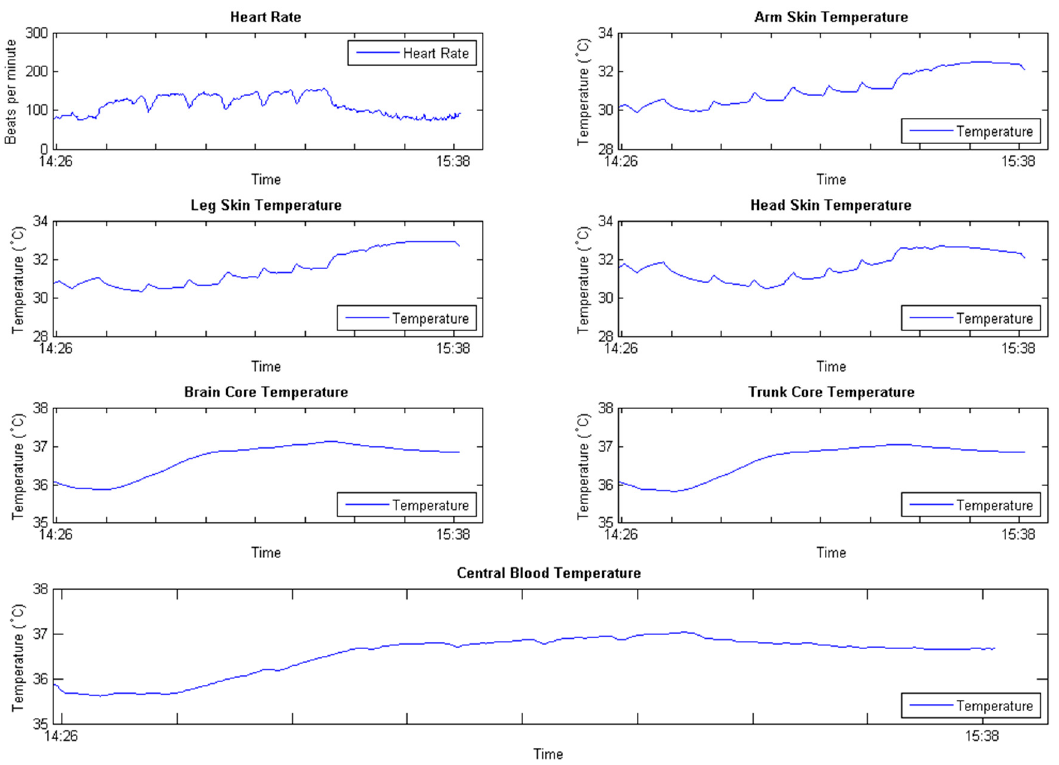
Figure 8. Analysis results from the proposed virtual sensing service containing heart rate measurements, and virtual temperature sensor readings of various parts of the body (female subject).